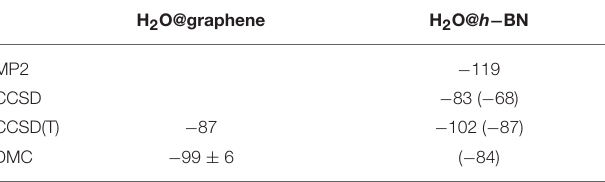
BN and graphene −